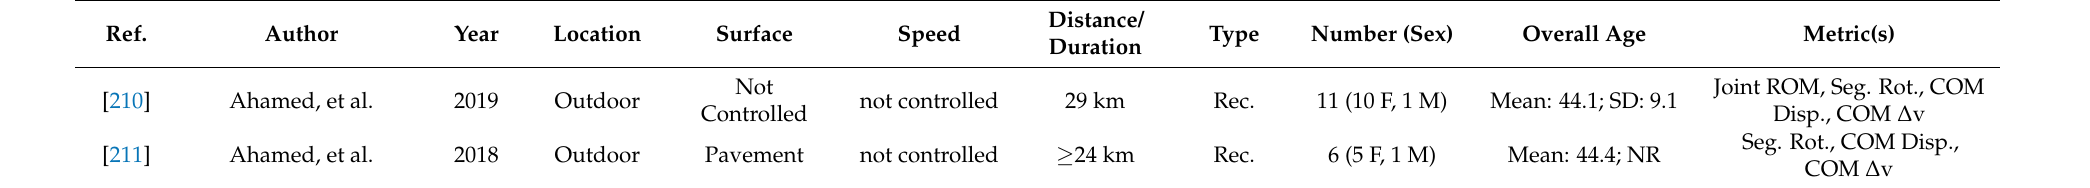
Table 5. Study characteristics where the analyzed distance is >1000 m over multiple runs.